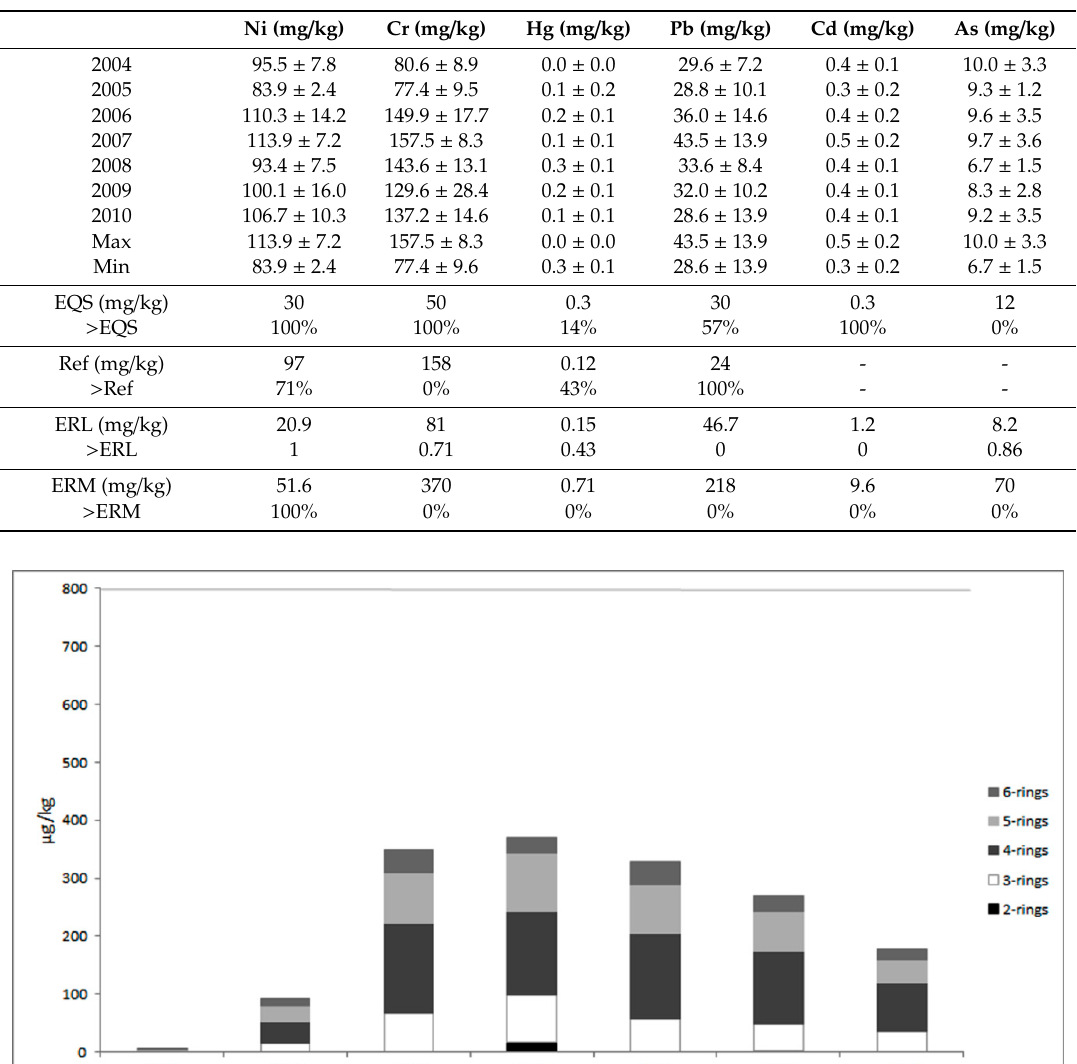
Table 1. Yearly average (±SD), maximum and minimum yearly concentrations of trace elements (TEs) from 2004 to 2010 in sediments of the Sacca di Goro (n = 4), threshold limits, and the number of years from 2004 to 2010 in which TEs’ concentrations exceeded those limits expressed in percentage. EQS = limits for ecological quality status (Good/Moderate) according to the Water Framework Directive (WFD); Ref = background levels of Ni, Pb, Cr and Hg for Po River Delta [18]; ERM = Effects Range- Low values [19]; ERL = Effects Range-Low values [19].